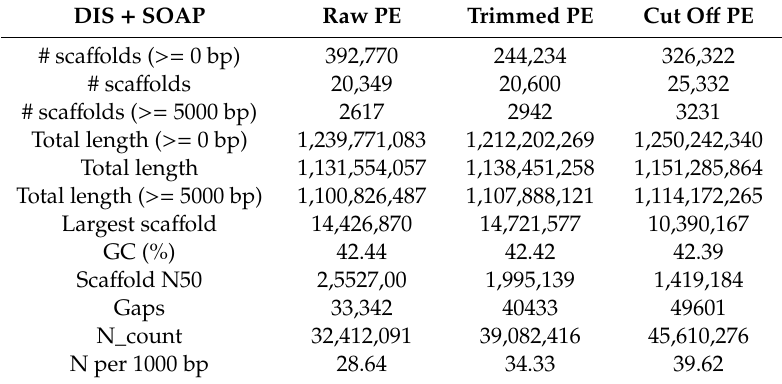
Table 2. De novo assembly results of rufous-capped babbler genomes based on three datasets using DISCOVARdenovo + SOAPdenovo2. The summaries are based on sca ff olds ≥ 1000 bp, with exceptions noted in the